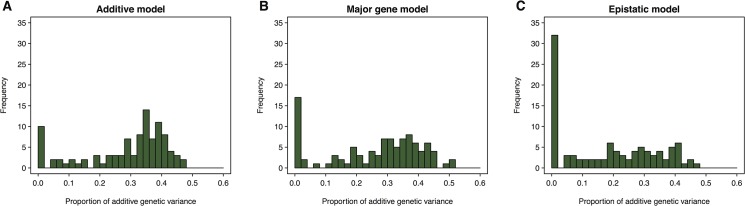
Genetic architecture affects estimated additive genetic variance.Different genetic architectures were simulated using DGRP genotypes for an additive model (A), a major gene model (B) or an epistatic model (C). Broad sense heritability was assumed to be 37%, the same as the observed chill coma recovery time. A total of 100 simulations were performed and the additive genetic variance (expressed as the proportion of additive genetic variance of total variance) was estimated and summarized in histograms.